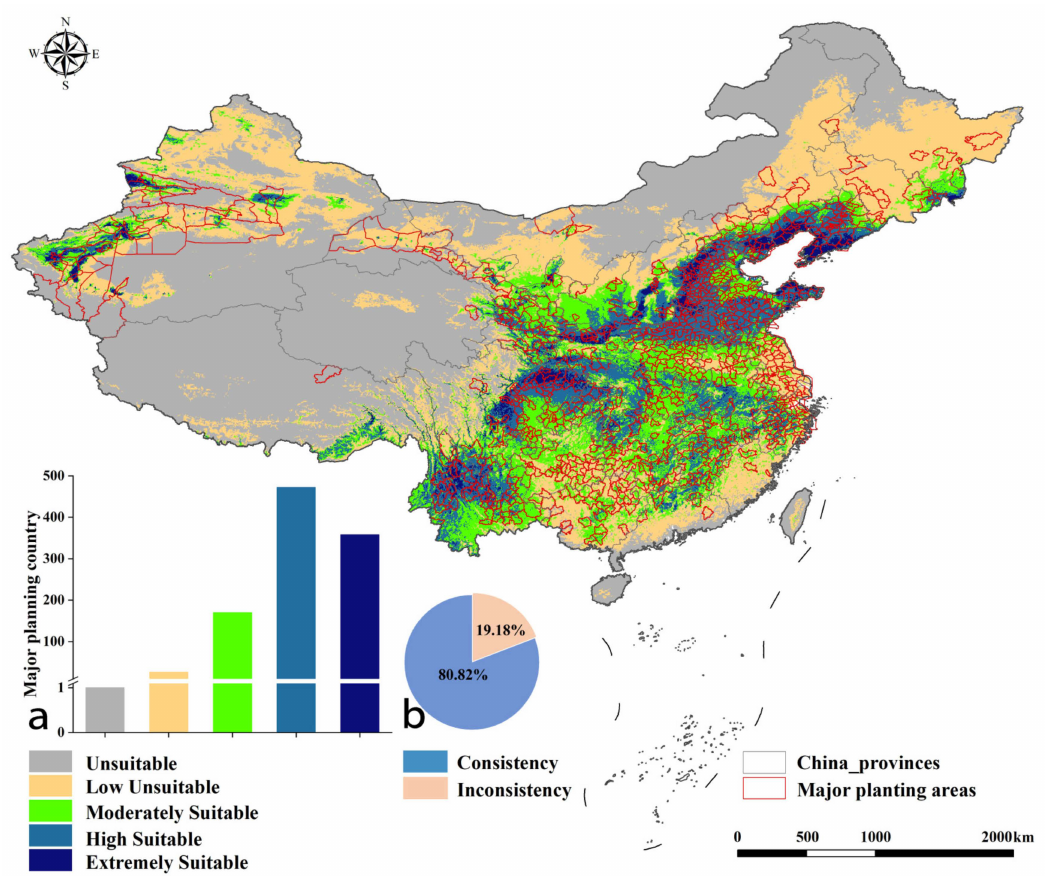
Figure 4. Consistency map of suitable regions and main production counties under current climatic conditions. Note: the bar chart ( a ) shows the number of main pear-producing counties located in different areas of habitat suitability, and the pie chart ( b ) shows the proportion of